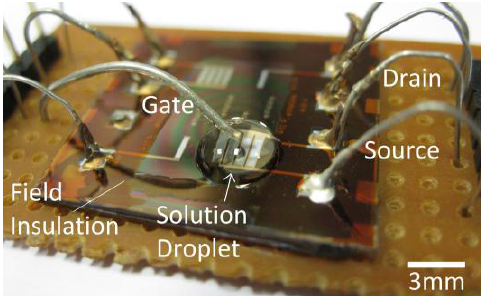
Figure 3. Device under